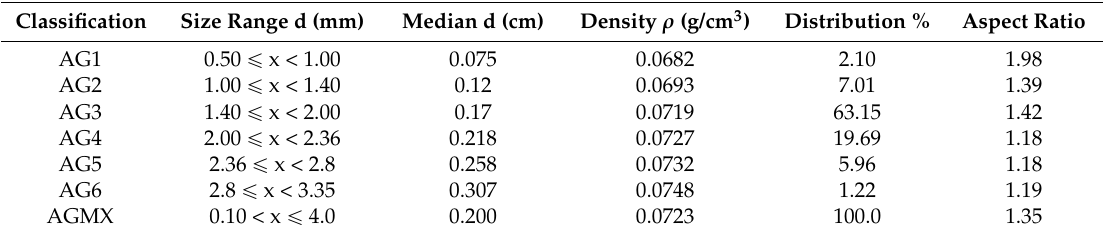
Table 3. Classification and physical properties of SA granule sizes.